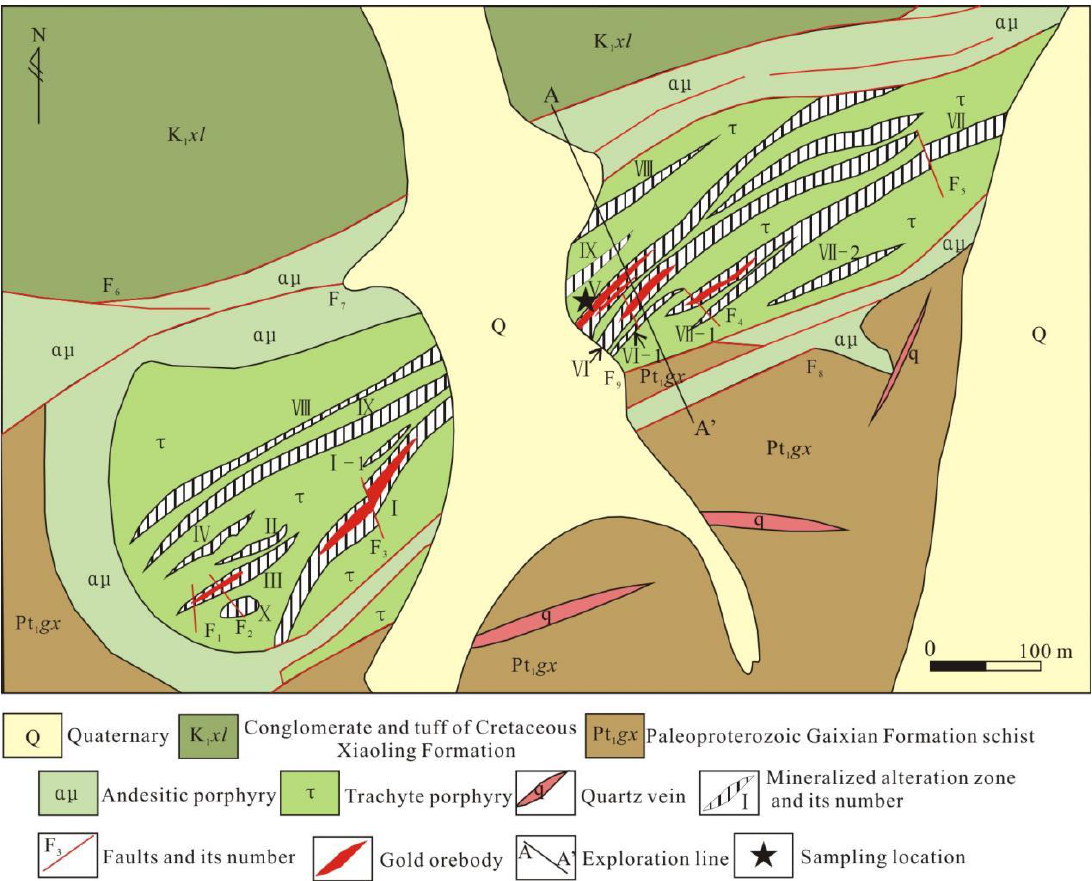
Figure 2. Geological map of the Dongpuzi gold deposit (modified from [5]).